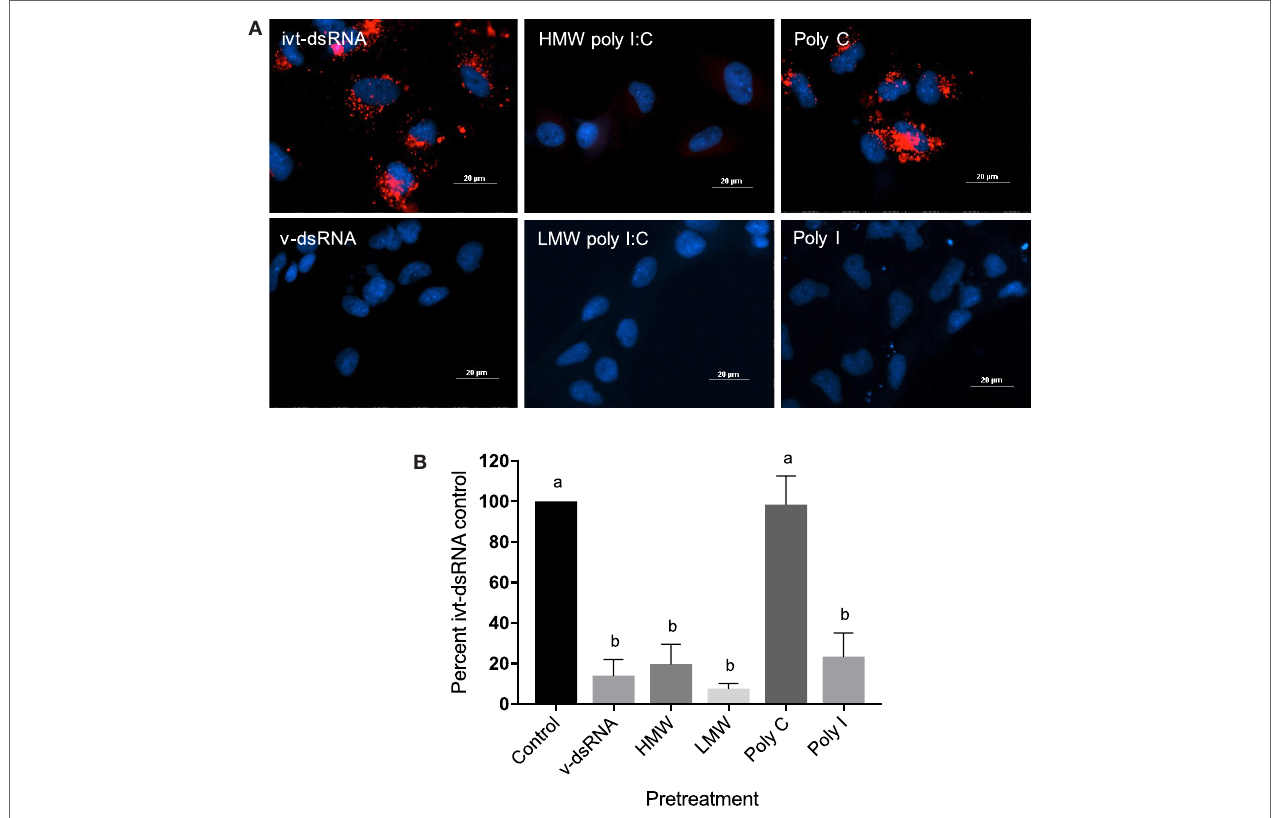
FigUre 1 | In vitro transcribed dsRNA, viral dsRNA, and polyinosinic:polycytidylic acid (poly I:C) bind the same class A scavenger receptor in RTgutGC cells. RTgutGC cells were pretreated for 3 h with high-molecular weight (HMW) poly I:C, low-molecular weight (LMW) poly I:C, poly I, or poly C at 100 µg/mL, or total chum salmon reovirus genome (v-dsRNA) at 40 µg/mL, or control media. Cells then received 1.25 µg (5 µg/mL) of Alexa Fluor 546 labeled CSVseg1 dsRNA (ivt-dsRNA) with 50 µg/mL of DEAE-dextran. 6 h posttreatment cells were formalin fixed, and nuclei were counterstained with diamidino-2-phenylindole; slides were visualized using an inverted fluorescence microscope (Nikon Eclipse TiE with Qi1 camera). (a) Representative images of cells with or without pretreatment, dsRNA = red, nuclei = blue. (b) Fluorescence intensity per cell was quantified using Nikon NIS-elements software and is presented as percent of the ivt-dsRNA only control, no pretreatment. Data represent three independent replicates and were analyzed statistically by one-way ANOVA, alpha = 0.05; a P value < 0.05 considered